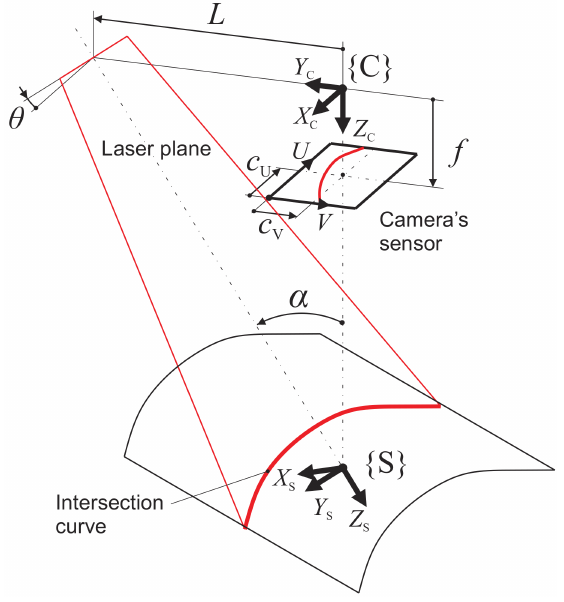
Figure 2. Sketch of the arrangement of the camera and the laser projector with their corresponding coordinate systems.